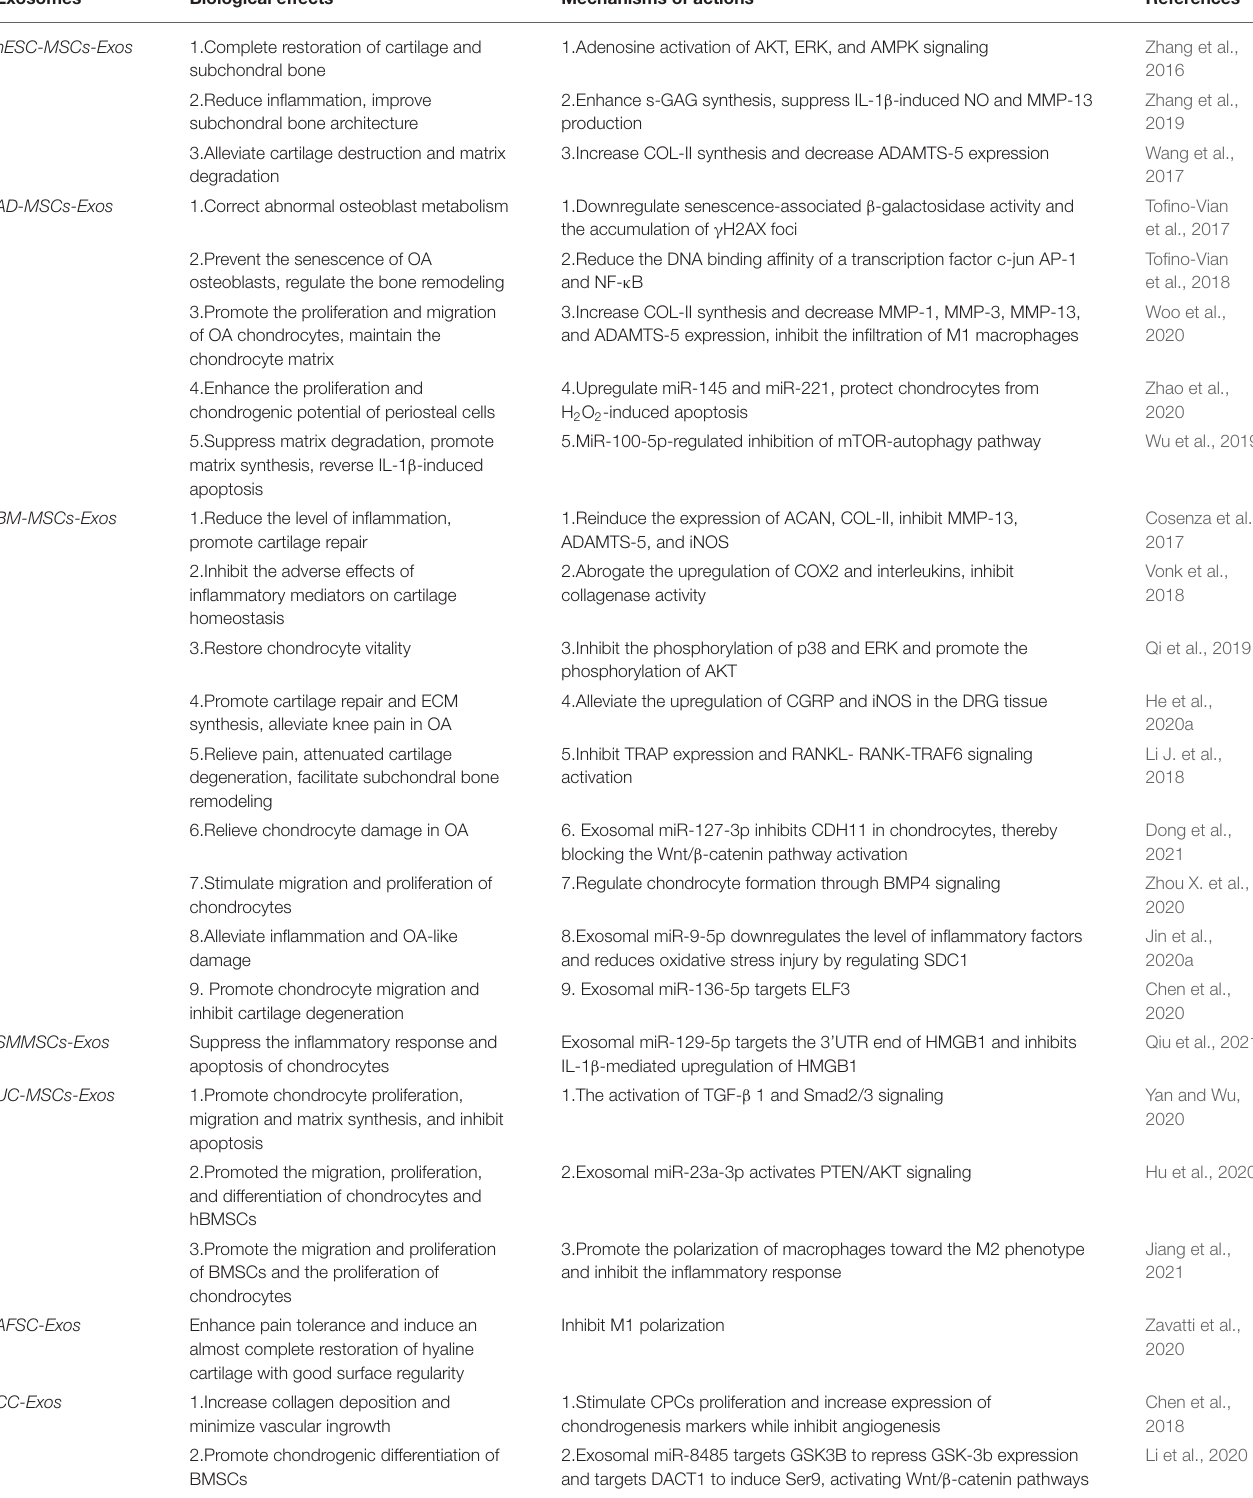
TABLE 3 | The therapeutic effects and underlying mechanisms of exosomes on articular cartilage defect/osteoarthritis